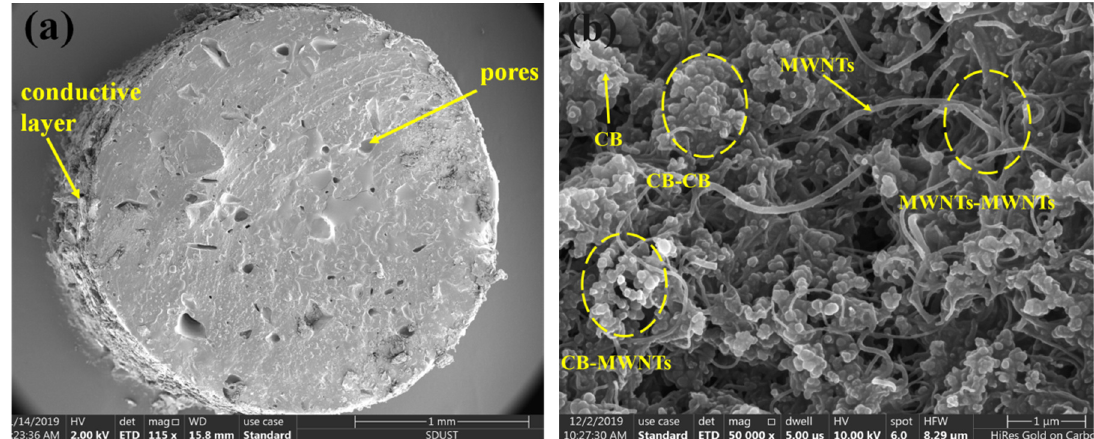
Figure 2. Scanning electron microscopy (SEM) diagram of the flexible strain sensor: ( a ) SEM diagram of the sensor, the porous structure inside the matrix, and the conductive layer on the surface of the matrix and ( b ) SEM image of the conductive network on the sensor surface and the three conductive connection channels (carbon black (CB)-CB, CB-carbon nanotubes (MWNTS), and